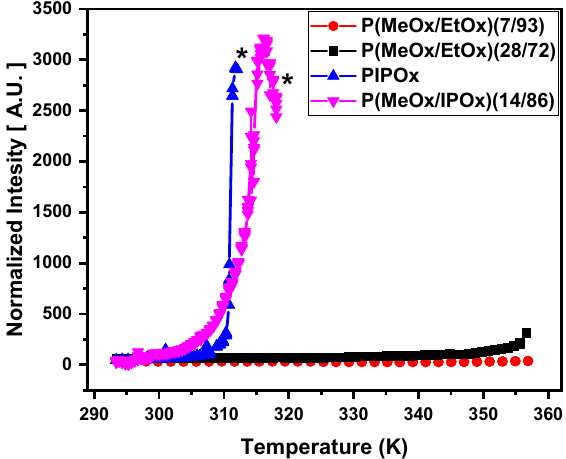
Figure 1. Temperature dependences of the intensity of scattered light in D 2 O solutions ( c = 5 wt%) of PIPOx homopolymer, P(MeOx- b -EtOx) and P(MeOx- b -IPOx) copolymers during gradual heating. Symbol “ * ” is related to precipitation of the sample.